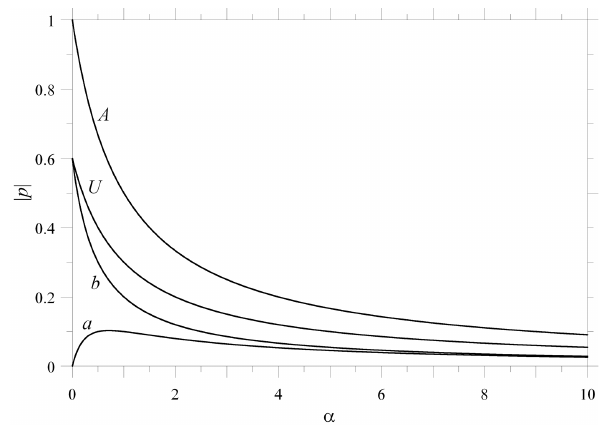
Fig. 6. The force difference 1F as a function of α ( (cid:15) = 0 .